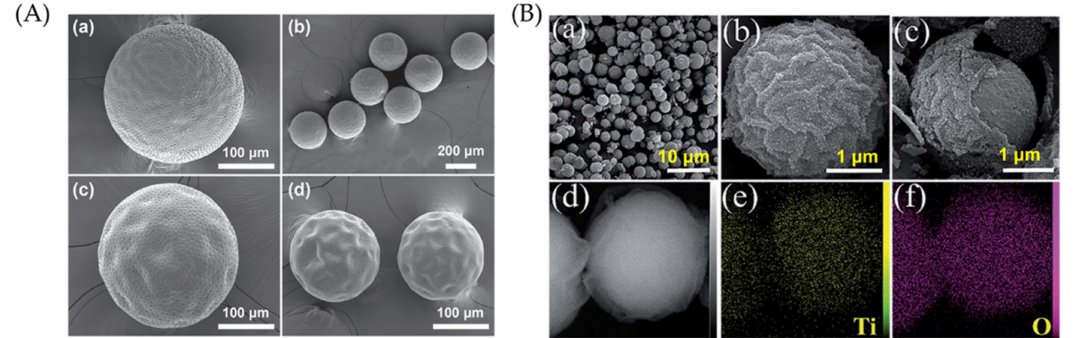
Figure 24. ( A ) SEM images of the dual-wrinkled microparticles from (a,b) PLGA/PDLA-b-mPEG blend and (c,d) PLGA/PCL-b-PEG-b-PCL blend. Reproduced with permission from reference [97]. Copyright 2018, Royal Society of Chemistry (RSC), and ( B ) FE-SEM (a–c), BSE-SEM (d), EDS mapping (e,f) images of the Y@HWS-TiO 2. Reproduced with permission from reference [98]. Copyright 2021, Elsevier